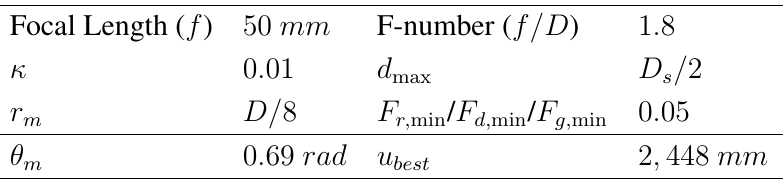
Table 1. Sensing parameters of adopted